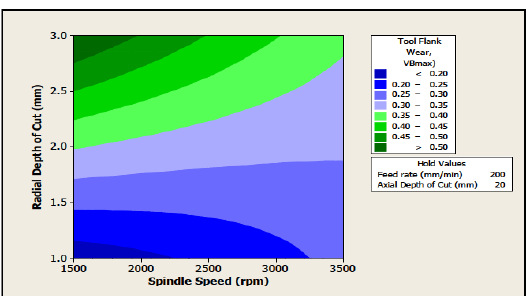
Figure 6: Contour plot of tool wear vs. axial depth of cut and feed